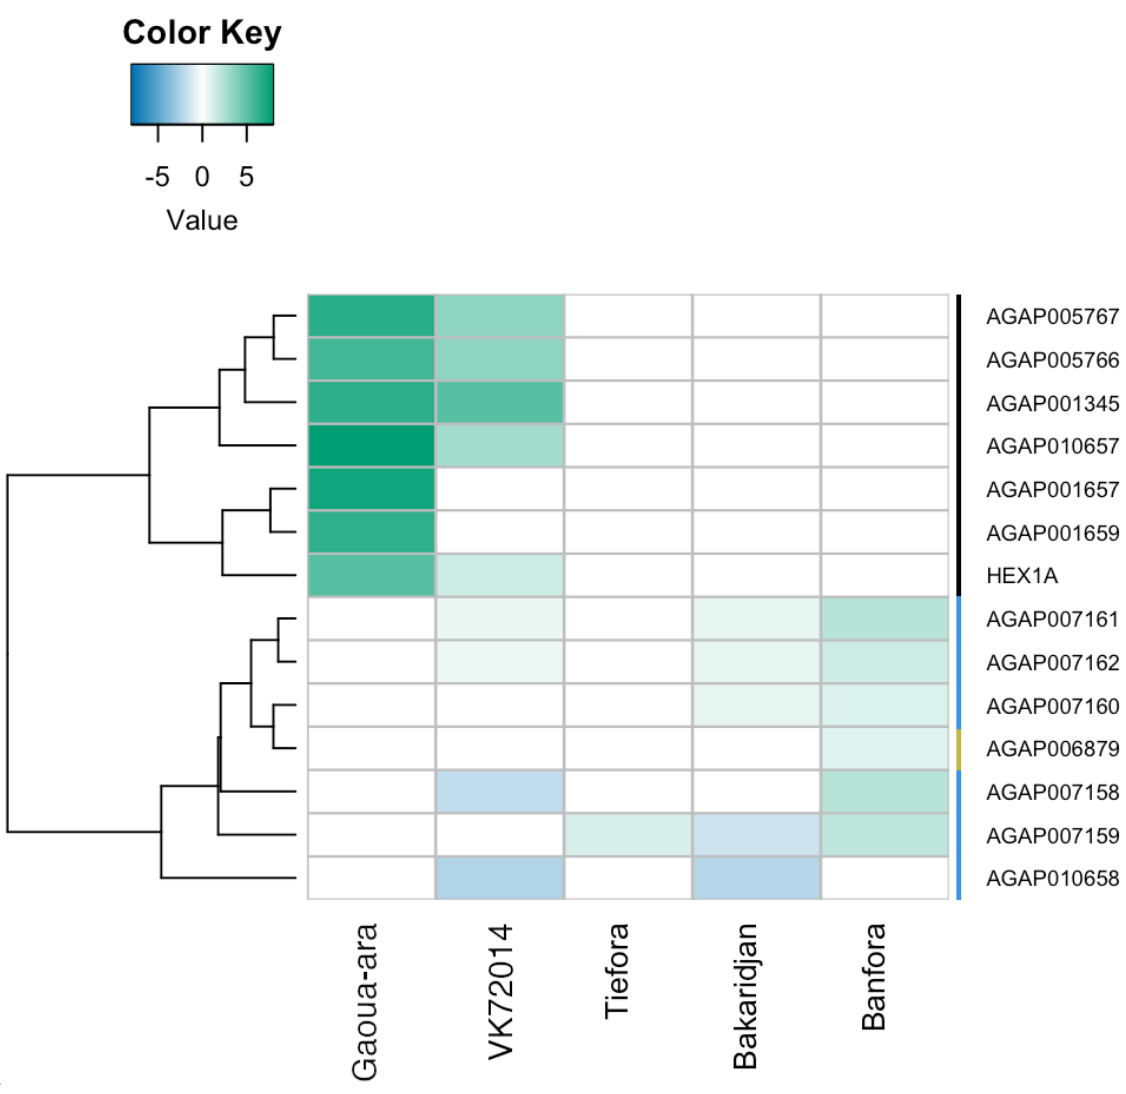
Figure 8. Heatmap showing differential expression of genes in families putatively associated with insecticide sequestration between the pyrethroid resistant and susceptible strains.